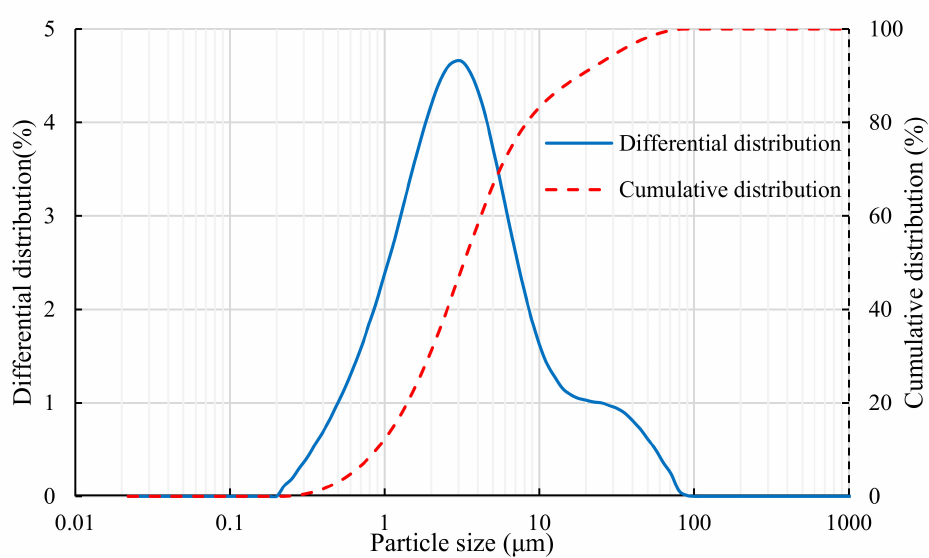
Figure 2. Particle size distribution of red mud from the Bayer process.